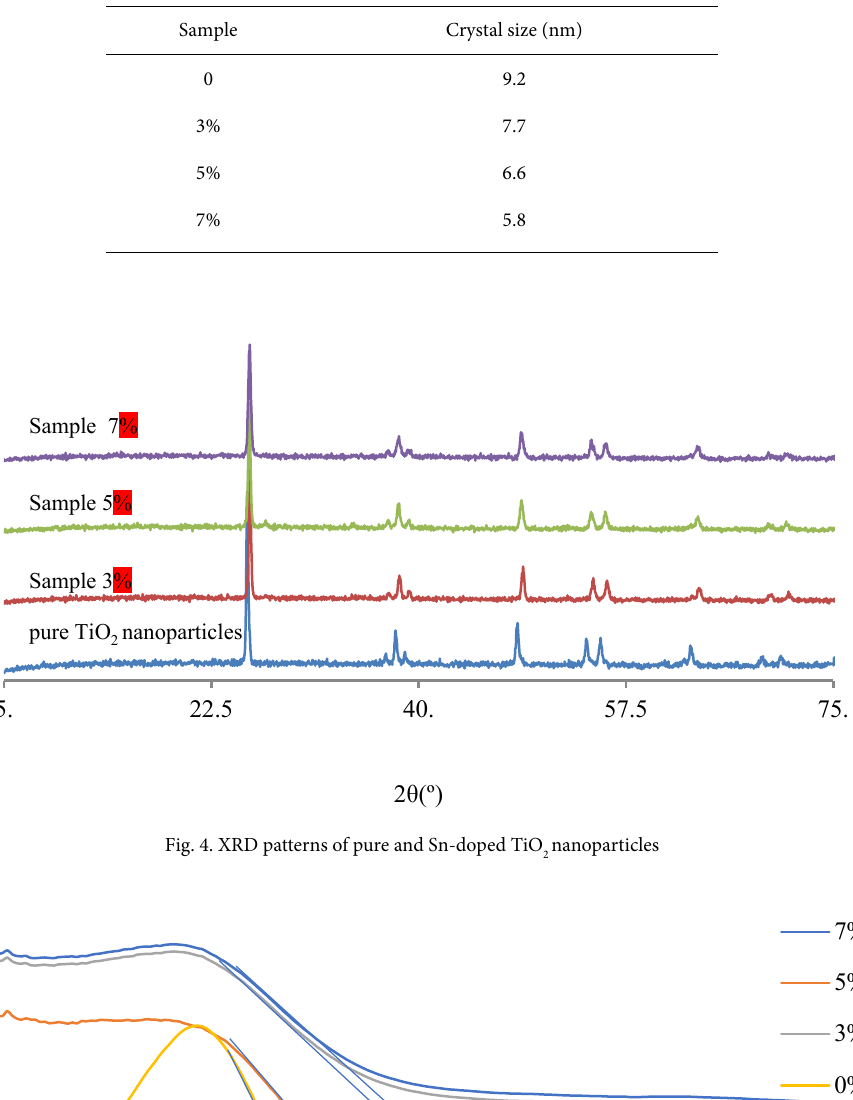
nanoparticles 2